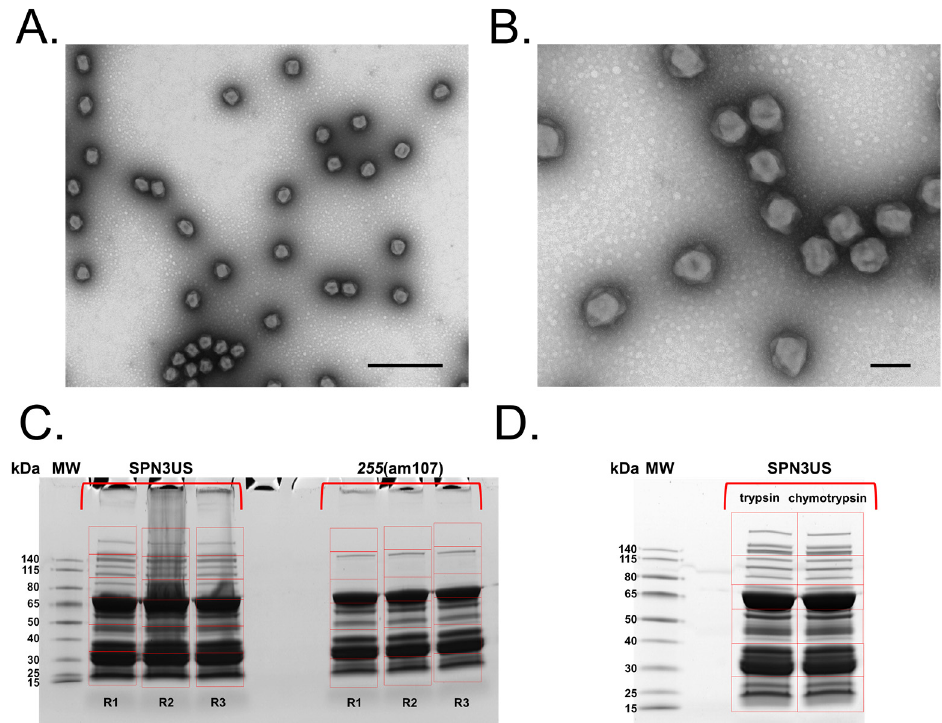
Figure 1. Transmission electron microscopy (TEM) and 1-D SDS-PAGE of Salmonella phage SPN3US. ( A , B ) TEM of head particles produced by Salmonella phage SPN3US mutant 255 (am107) grown under non-permissive conditions and stained with uranyl acetate. Space bars represent 500 nm ( A ) and 100 nm ( B ). ( C , D ) 1-D SDS-PAGE of SPN3US. Gel slices excised for mass spectrometry analysis are indicated in red. ( C ) 1-D SDS PAGE of replicate samples (R1-R3) of wild-type SPN3US and heads from mutant 255 (am107). Proteins were analyzed on a Thermo Fisher Orbitrap Fusion Lumos mass spectrometer after digestion with trypsin ( D ) Wild-type SPN3US proteins were digested with either trypsin or chymotrypsin prior to mass spectrometry analyses on a Thermo Fisher Orbitrap